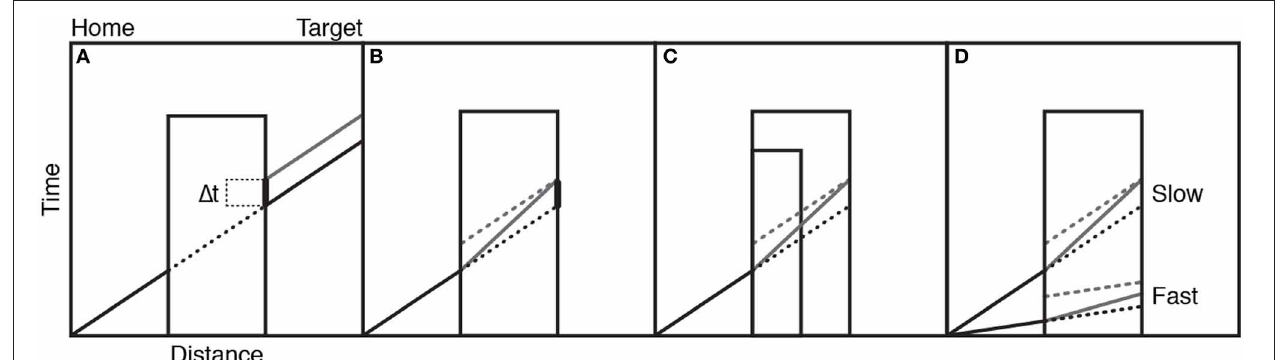
FIGURE 6 | Panel (A) shows the actual movement of an object behind the occluder (black lines) and the action simulation (gray line) illustrating lag error. Panel (B) shows two sources of the lag error: intercept (dotted gray) and slope (solid gray) lines. Panel (C) shows the different predictions of the two